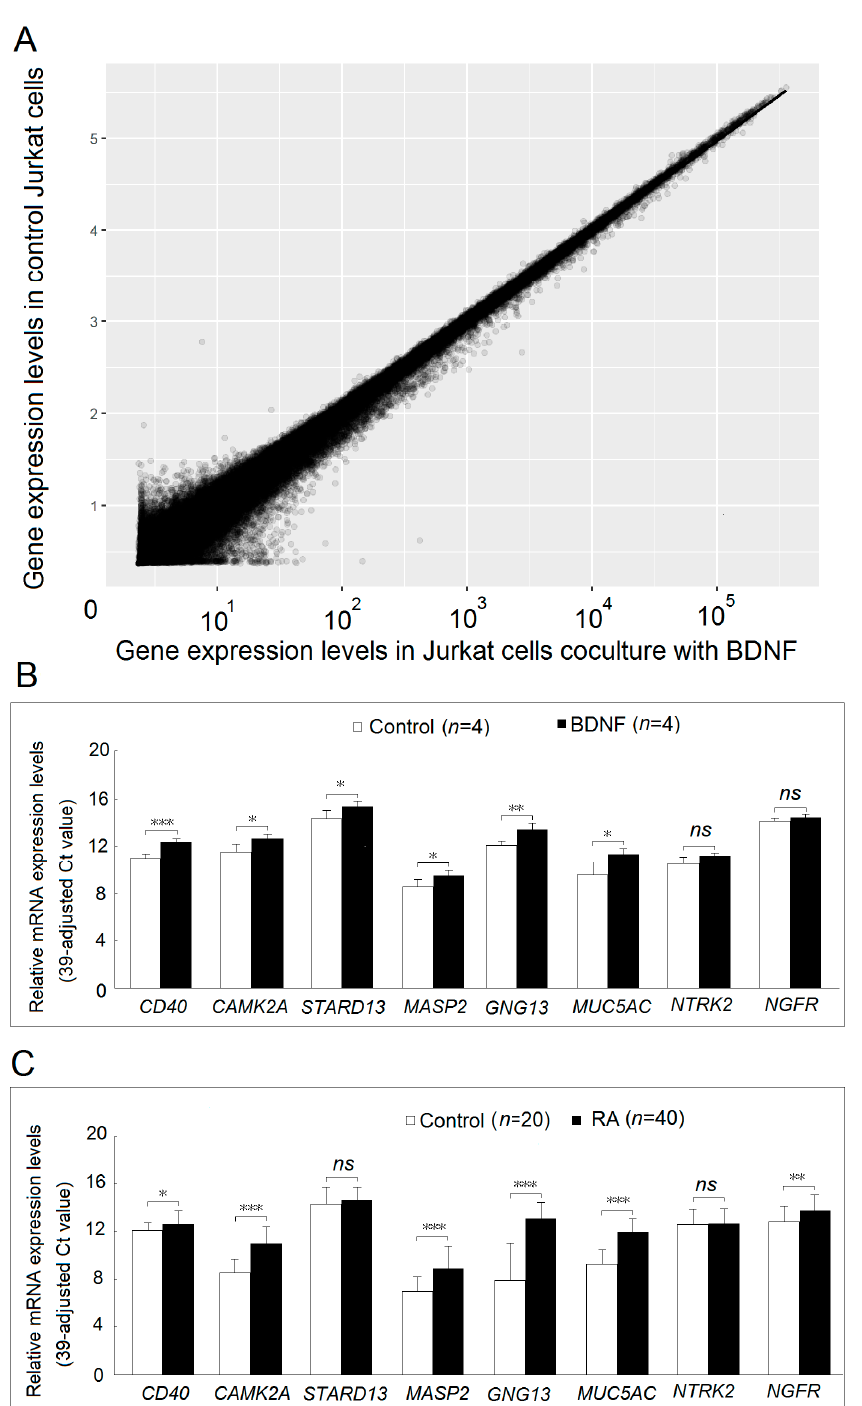
Figure 4. Identification and validation of BDNF regulated gene and its expression levels in T cells from patients with rheumatoid arthritis and healthy controls. ( A ) Expression profiles of mRNAs in Jurkat cells cocultured with BDNF 200 ng/mL or culture medium for 48 h were evaluated using microarray analysis. Each scatter spot represents the mean raw signal of mRNA in three repeats of each treatment. ( B ) Six genes, including CD40 , CAMK2A , STARD13 , MASP2 , GNG13 , and MUC5AC , which are related to the inflammatory pathway, were validated using real-time PCR. The expression levels of the BDNF receptors: NTRK2 and NGFR were compared in Jurkat cells cocultured with BDNF 200 ng/mL or culture medium for 48 hours. ( C ) The expressed levels of CD40 , CAMK2A , STARD13 , MASP2 , GNG13 , MUC5AC , NTRK2 , and NGFR were compared in T cells from healthy controls and patients with rheumatoid arthritis. ( ns , not significant; * p < 0.05; ** p < 0.01; *** p <